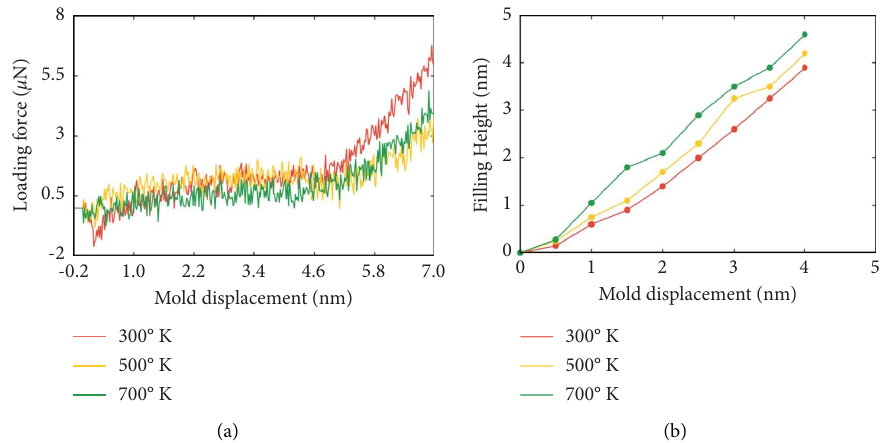
Figure 8: (a) Loading force and (b) flling height as a function of mold displacement for the groove pattern imprinting process.